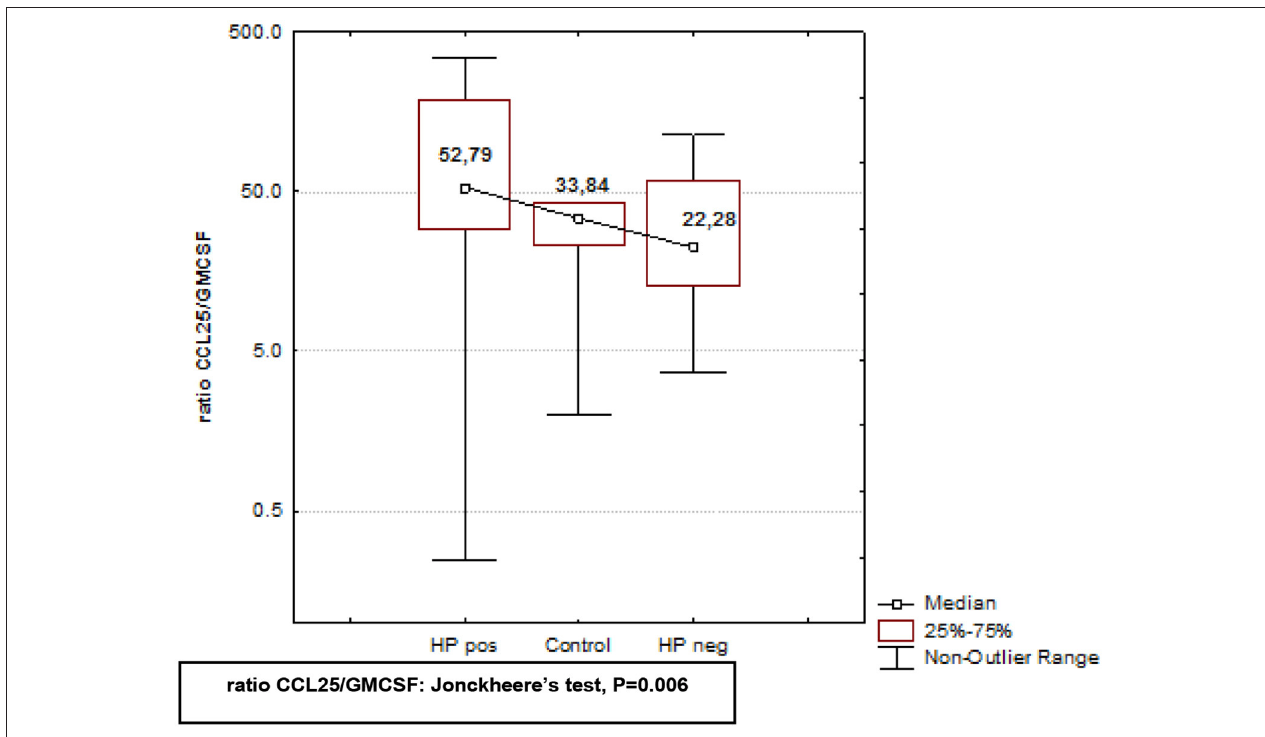
FIGURE 3 | Analysis of CCL25/GMCSF ratio in H. pylori positive and negative subjects, and healthy controls. CCL25/GMCSF ratio in serum of H. pylori positive, H. pylori negative, and healthy controls was analyzed using using Kruskal–Wallis ANOVA by Ranks test, followed by the post-hoc non-parametric Jonckheere’s-test for ordered medians. CCL25/GM-CSF ratio differed significantly between H. pylori positive and H. pylori negative subjects, and healthy controls ( P =